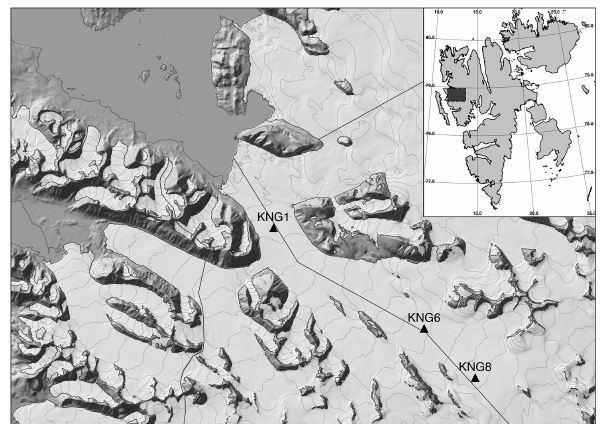
Figure 1. A map showing the location of the Kongsvegen glacier and the position of the automatic weather stations KNG8, KNG6, and KNG1 (Norwegian Polar Institute,